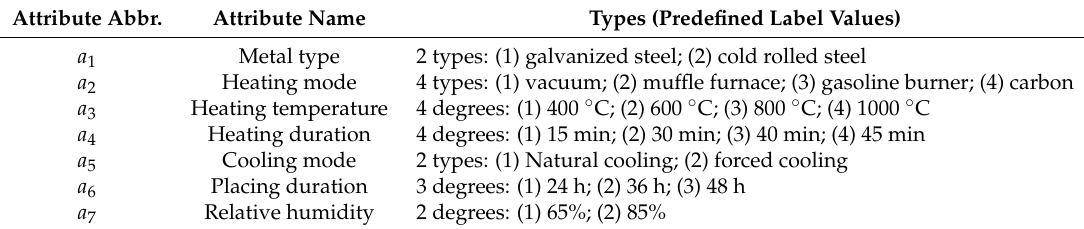
Table 2. Attributes of heated metal defined in this study.